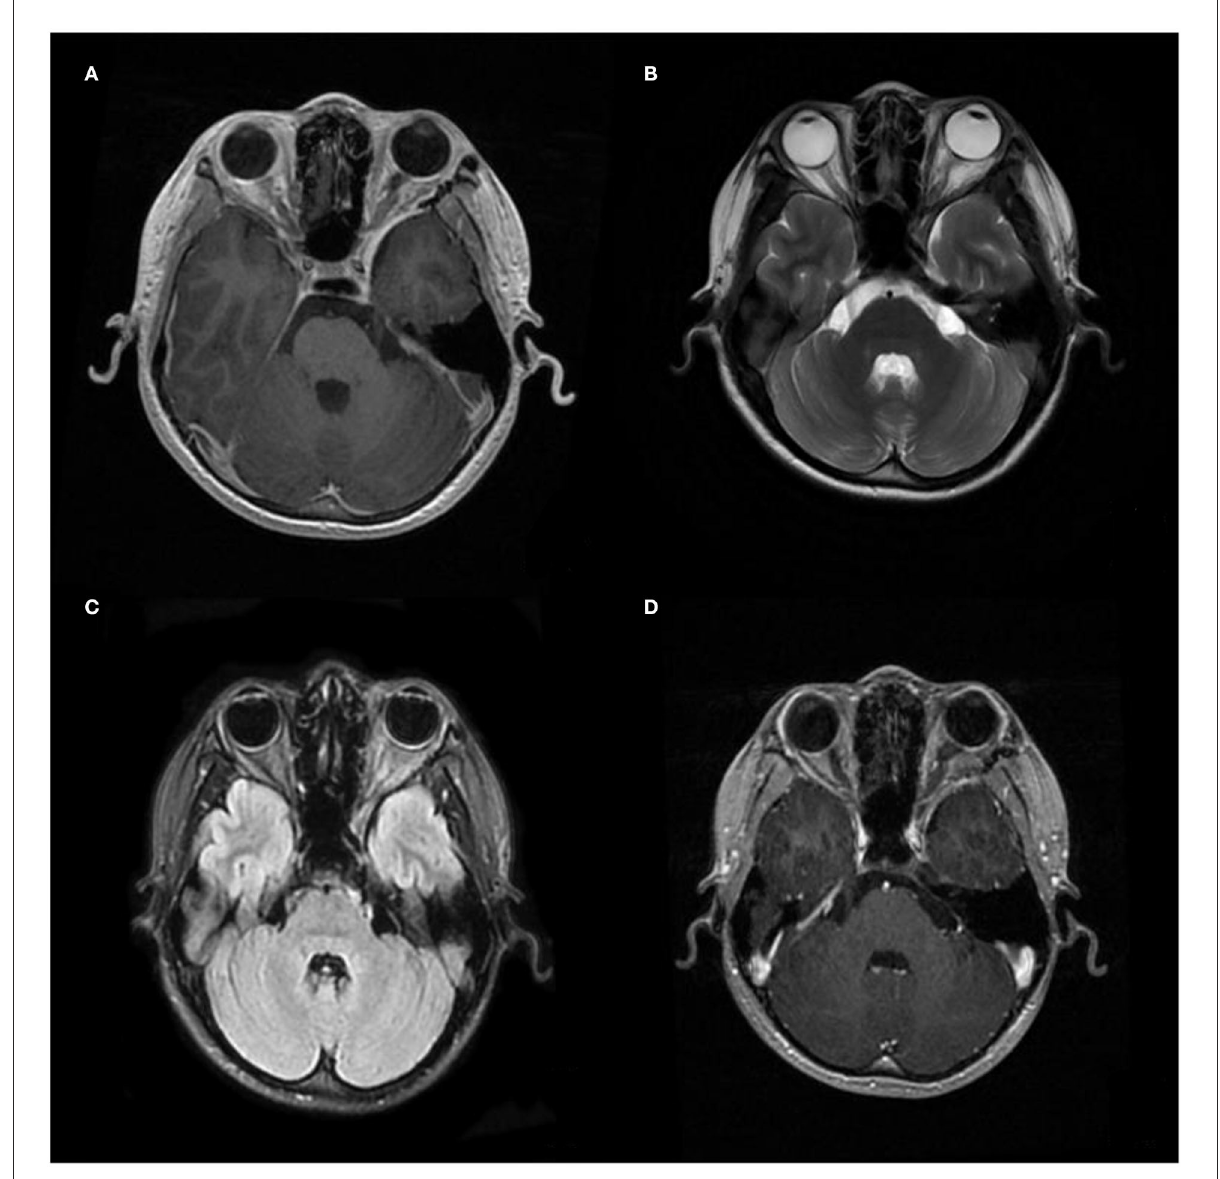
FIGURE3 Postoperative image of MRI. (A–C) Images of T1WI, T2WI, and Flair, and (D) images after gadolinium (Gd) injection were performed 3 months after the operation, respectively, showing no recurrence.